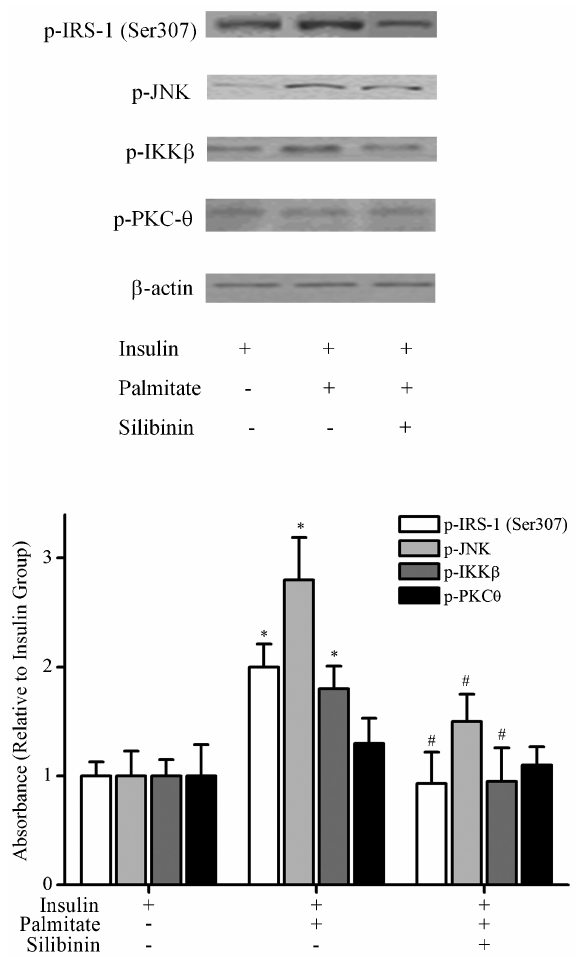
Figure 6. Silibinin modulated the phosphorylation of IRS-1 Ser307, JNK, IKK b but not PKC- h in skeletal muscle cells. Differentiated C2C12 skeletal muscle cells were incubated with palmitate (0.75 mM) or silibinin (100 m g/mL) + + palmitate, then stimulated with insulin (100 nM) before cells were harvested for Western blotting. Data are reported as means±SD of 4 determinations. *P , 0.05, compared to insulin group; # P , 0.05, compared to palmitate group in the presence of insulin (Student’s t glucose uptake in skeletal muscle cells (22). These to the use of different cells and tissues. Both the increases of